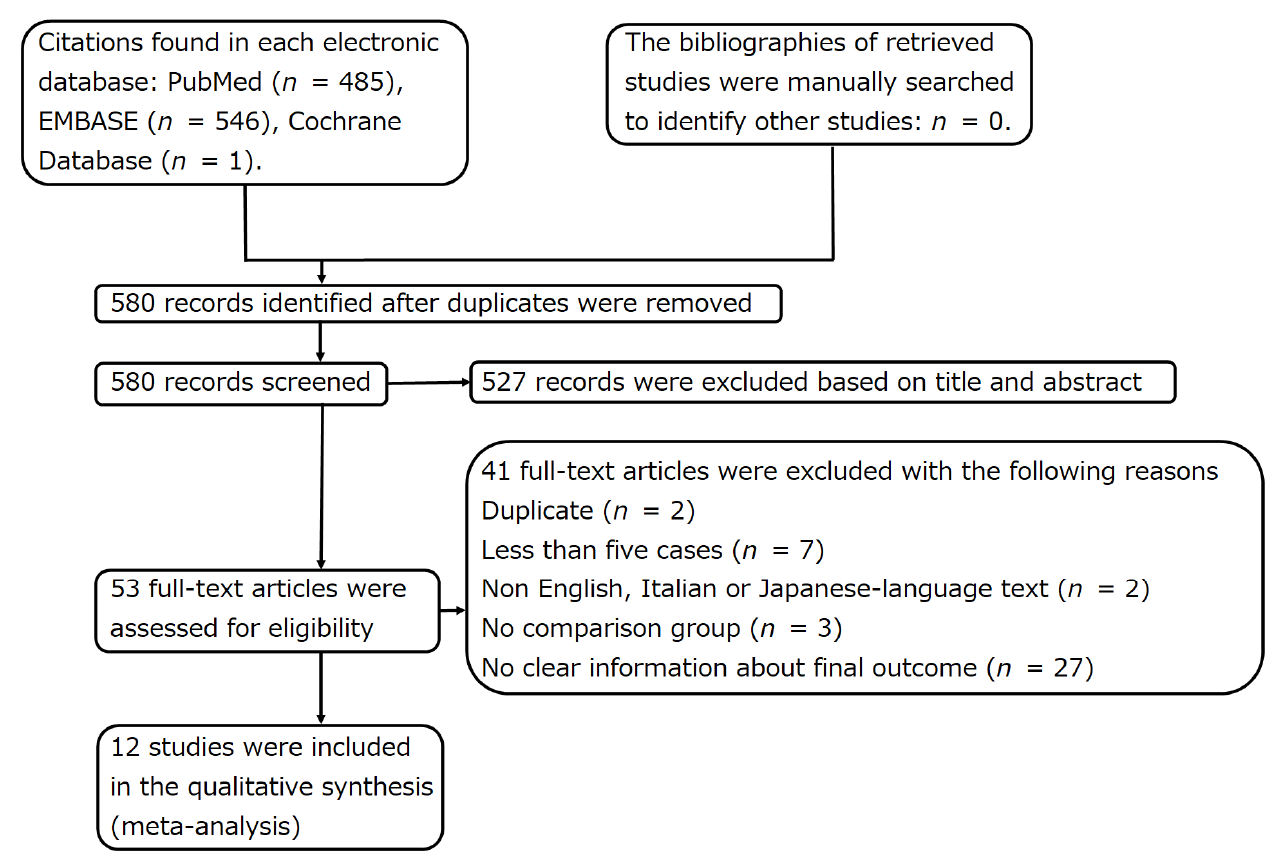
Figure 2. This flow chart shows the flow of database search used to identify relevant articles.